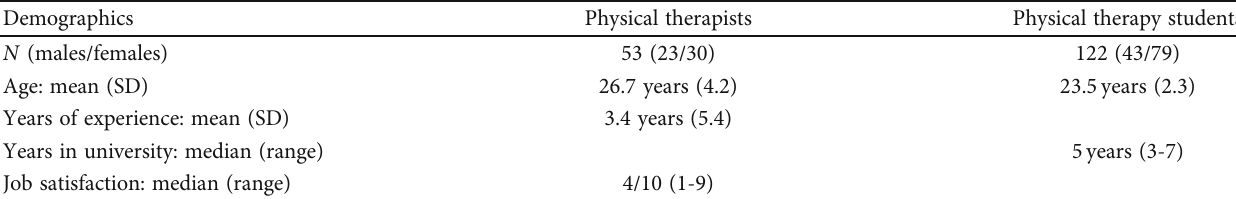
Table 1: Participants ’ characteristics.